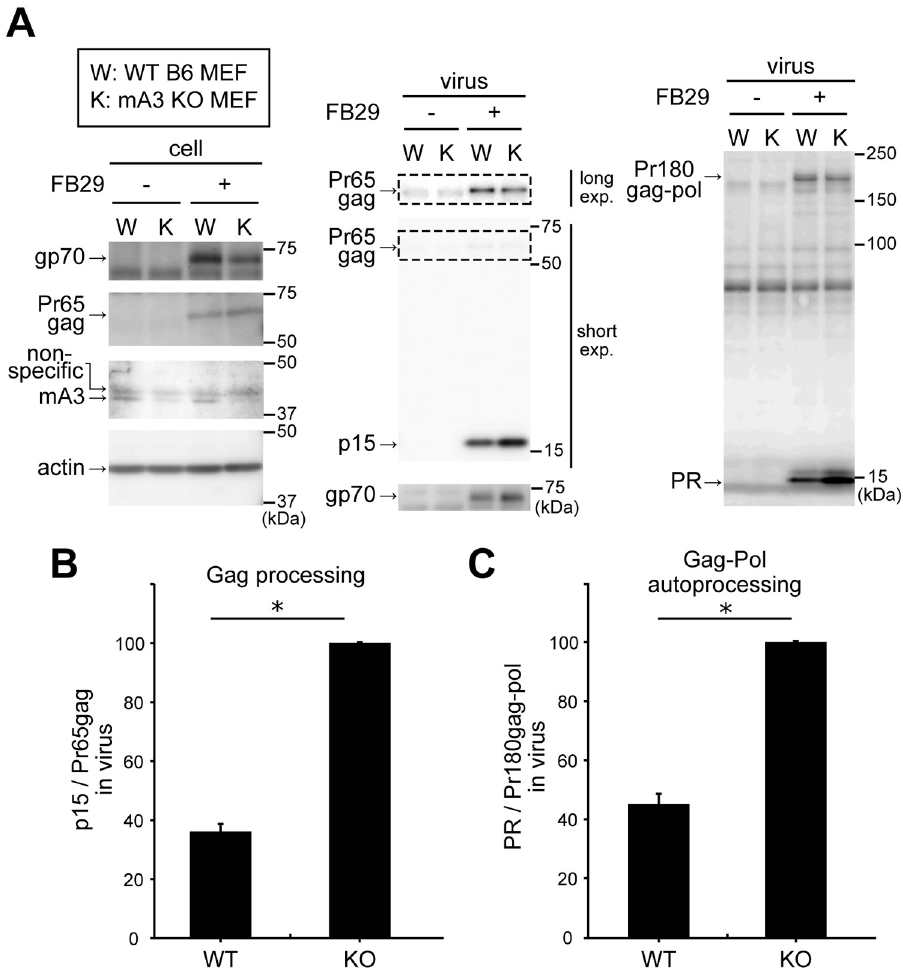
Fig 4. Physiologically relevant amounts of mA3 suffice for the inhibition of Pr65gag processing and perturbation of Pr180gag-pol autoprocessing. (A) MEF cells of WT (W) and mA3 KO (K) B6 mice were infected with F-MuLV FB29 (+) or mock infected ( − ). At a day after infection, the cells were treated with LPS. At 3 days postinfection, produced viruses and the cells were harvested and analyzed by immunoblotting. Anti-p15 (MA) mAb clone 690, anti- F-MuLV gp70 (SU) mAb clone 720, and anti-actin Ab C-11 were used to detect p15 and Pr65gag, gp70, and cellular actin, respectively. For the detection of PR and Pr180gag-pol, the rabbit anti-MuLV protease Ab was used. The anti- mA3 Ab was pre-absorbed with mA3 KO spleen extract, and used for the detection of endogenous mA3. Pr65gag signals detectable after a long exposure time are also shown. (B) Band intensities of p15 and Pr65gag on the same blot as shown in the middle part of panel A were measured, and p15/Pr65gag ratios were calculated and expressed by setting the ratio for the KO sample as 100 for each experiment. The data represent the mean with standard error from three independent experiments. � , P = 0.0015 by one-sample t -test comparing to the value 100. (C) Band intensities of mature viral protease and Pr180gag-pol on the same blot as shown in the right part of panel A were measured and PR/ Pr180gag-pol ratios were calculated as above. The data represent the mean with standard error from three independent experiments. � , P = 0.0035 by one-sample t -test comparing to the value 100.